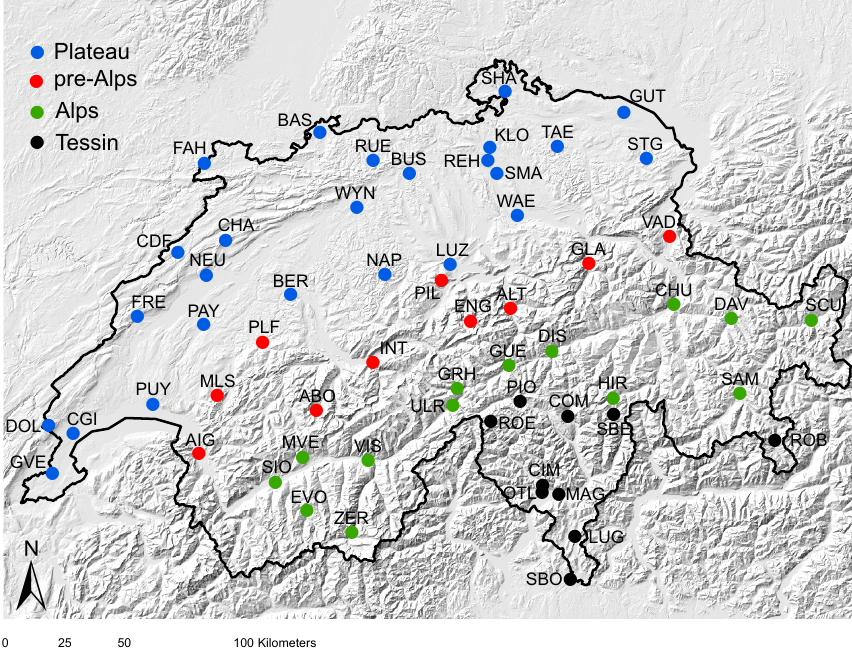
Figure 1. Map of the 59 analysed stations in Switzerland divided into four regions: Plateau, pre-Alps, Alps and Tessin. The labels list station codes. The Tessin region represents all stations that are in valleys facing south of the main Alpine